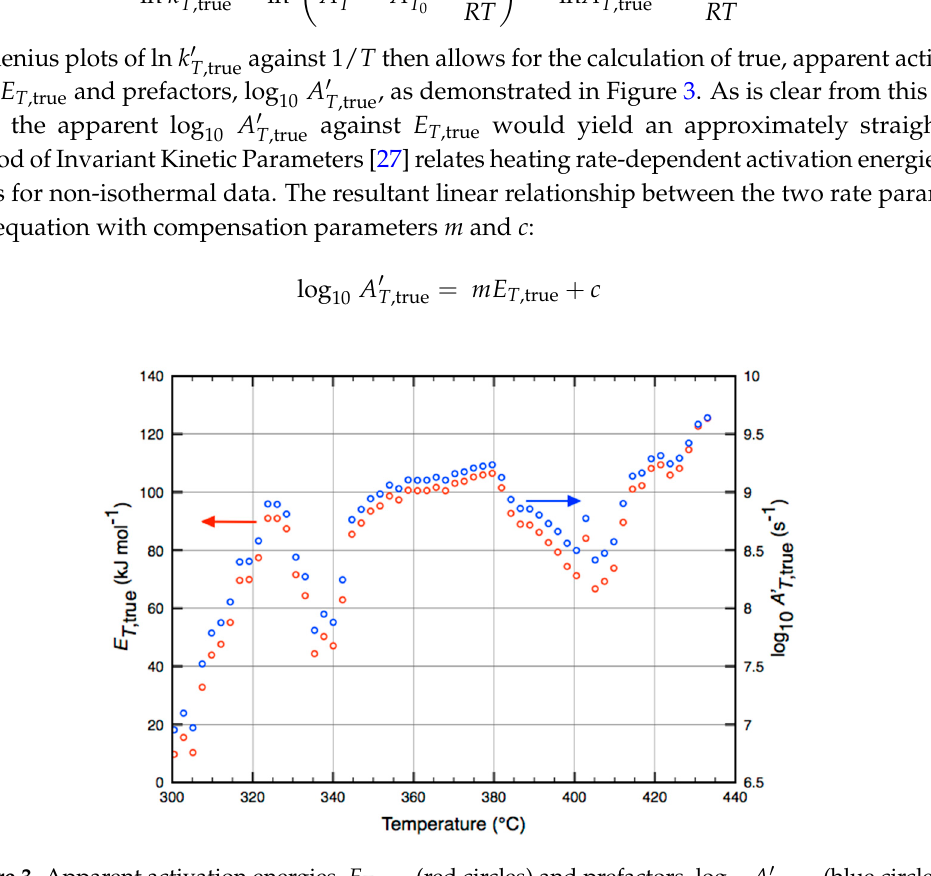
Figure 3. Apparent activation energies, E T ,true (red circles) and prefactors, log plotted against temperature for the evolution of methacrolein during temperature-programmed oxidation of isobutane over phosphomolybdic acid (3 rd run).